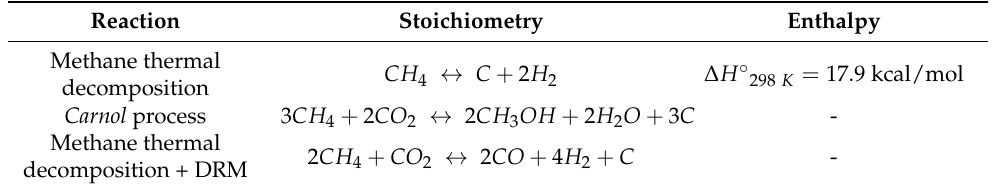
Table 21. Main reactions involved in the Carnol process.